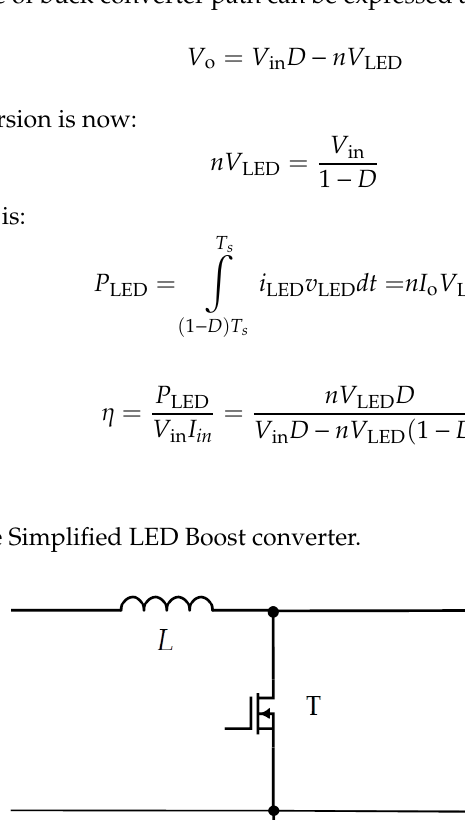
GND Figure 9. Simplified LED buck–boost converter. The output voltage of the buck–boost converter can be expressed as: